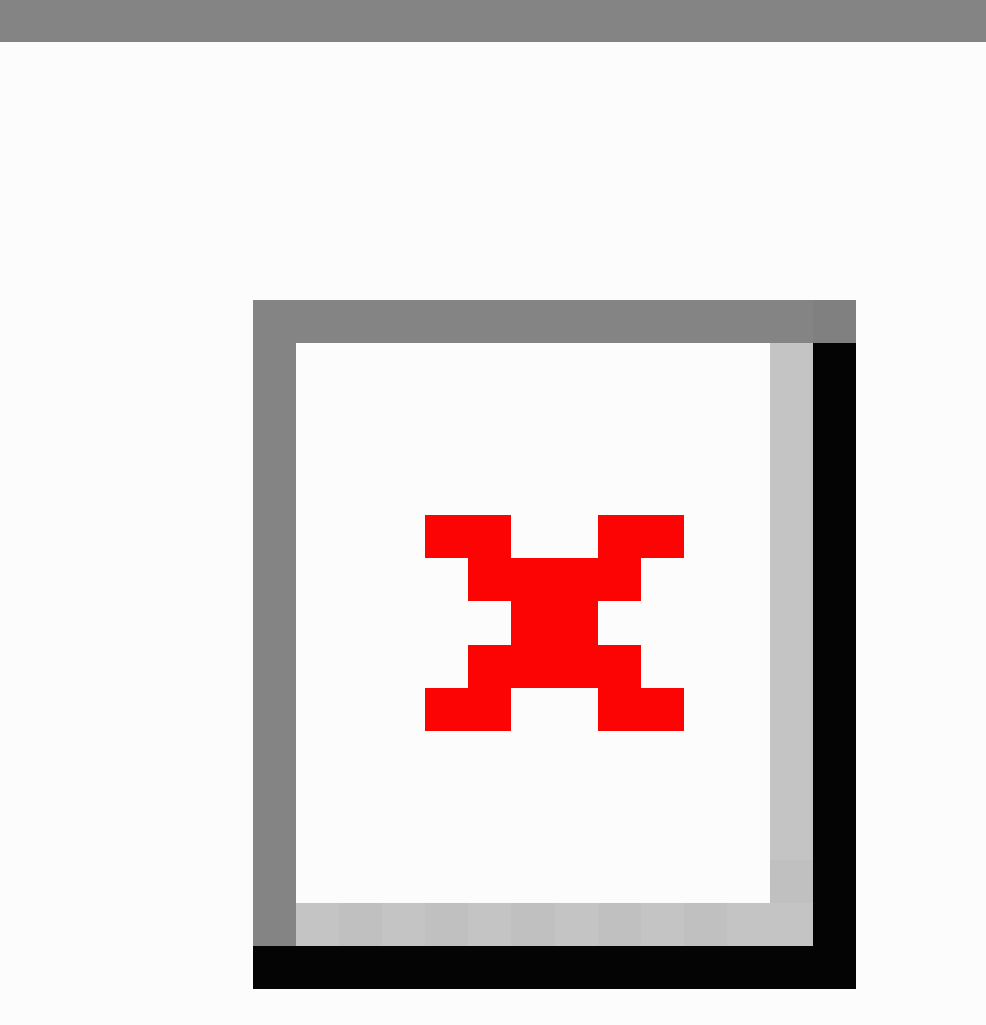
Figure 1. Screenshots of the final app. A. Modified camera screen. B. Image review screen where participants can choose whether to keep the image they have taken or try again. C. Review screen of all added images; up to 4 images may be added. D. A series of yes or no questions follow. E. Participants can review their survey responses and have the option to change them prior to submission. F. Submission confirmation